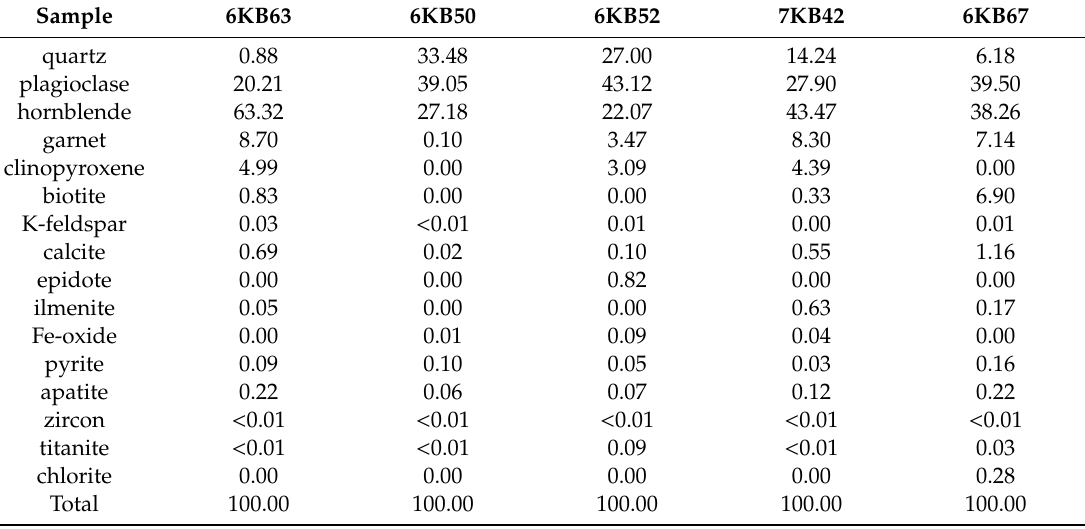
Table 1. Modal mineral abundances of the Kapuskasing Structural Zone (KSZ) samples from SEM-EDS phase